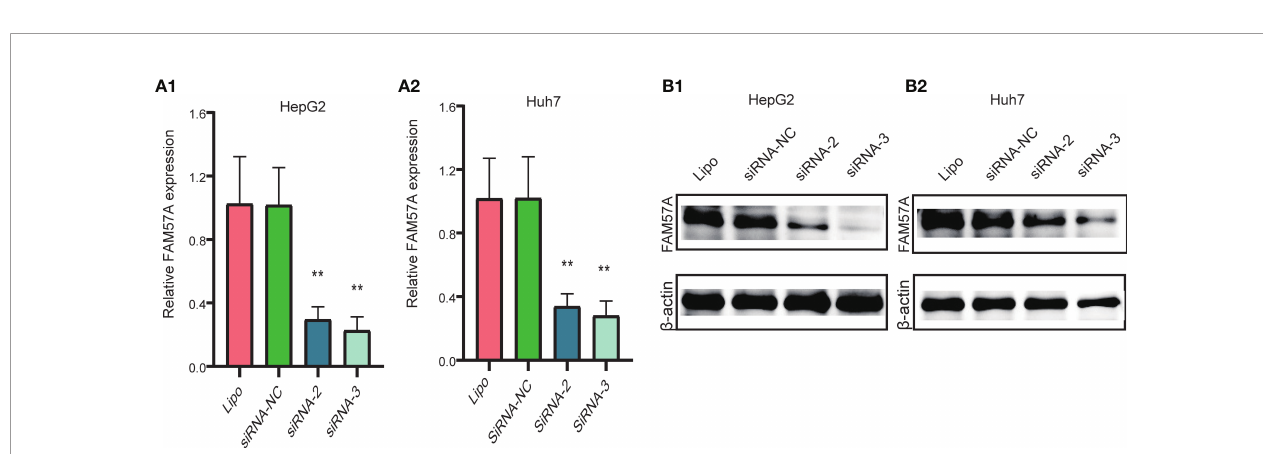
FIGURE 8 | The top 10 of GO terms and KEGG pathways associated with the coexpression genes of FAM57A. (A) GO terms (including BP, CC, and MF). (B) KEGG pathways. BP, biological process; CC, cellular component; MF, molecular function; GO, Gene Ontology; KEGG, Kyoto Encyclopedia of Genes and Genomes.